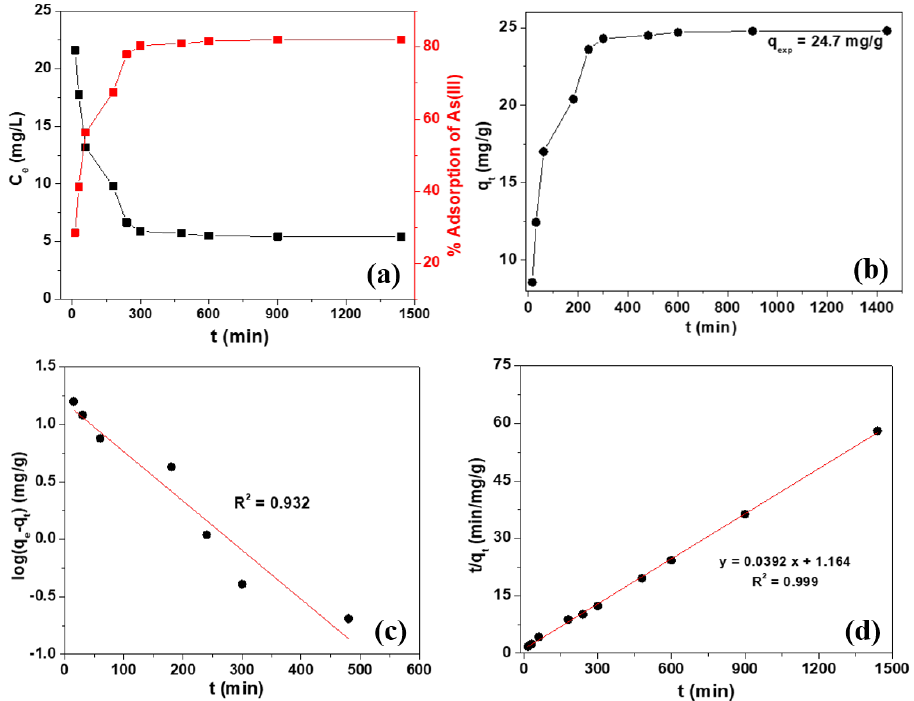
(0.999), indicating the adsorption is chemisorption.